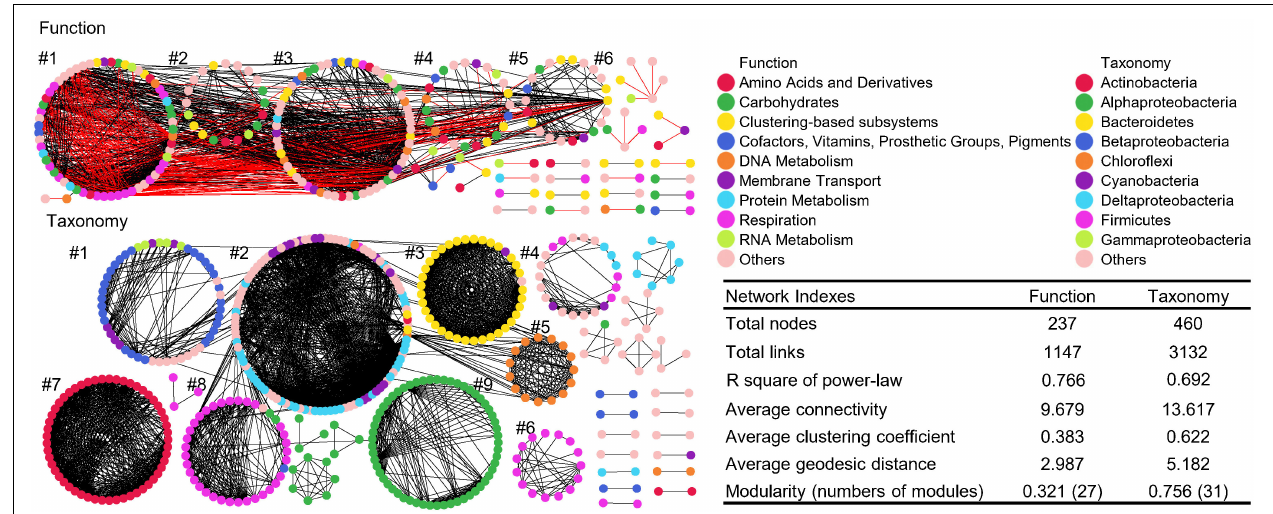
FIGURE 6 | Co-occurrence networks of functional and taxonomic compositions. Network graphs with submodule structures of soil metagenomes annotated in the SEED Subsystems database at Level 3 (Function) and RefSeq database at genus level (Taxonomy). Node color represents classification of Subsystems database at Level 1 or RefSeq database at phylum/class levels. A black edge indicated a positive interaction between two nodes, while a red edge indicated a negative interaction. Summary of key network indexes is given in the table.